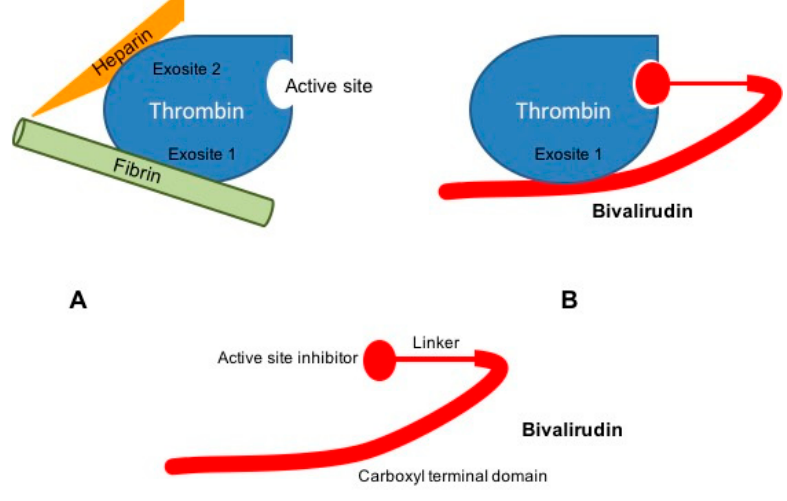
Figure 2. Mechanisms of action of bivalirudin. ( A ) The ternary heparin-thrombin-fibrin complex increases the affinity of thrombin for its fibrin substrate. Heparin binds thrombin via exosite 2, while interaction of thrombin to fibrinogen occurs through exosite 1; ( B ) Bivalirudin binds to thrombin both via the active site and exosite 1, blocking the interaction between thrombin and fibrinogen; ( C ) Bivalirudin consists of 20 aminoacids disposed in three structural domains: a catalytic site domain, a carboxyl terminal region and a linking domain. 4. Bivalirudin Pharmacokinetics and Pharmacodynamics Bivalirudin does not bind to plasma proteins or to red blood cells [38,56]. It is cleared with a mean total body clearance of 3.4 mL/kg per minute and the elimination half-life is over 25 min in patients